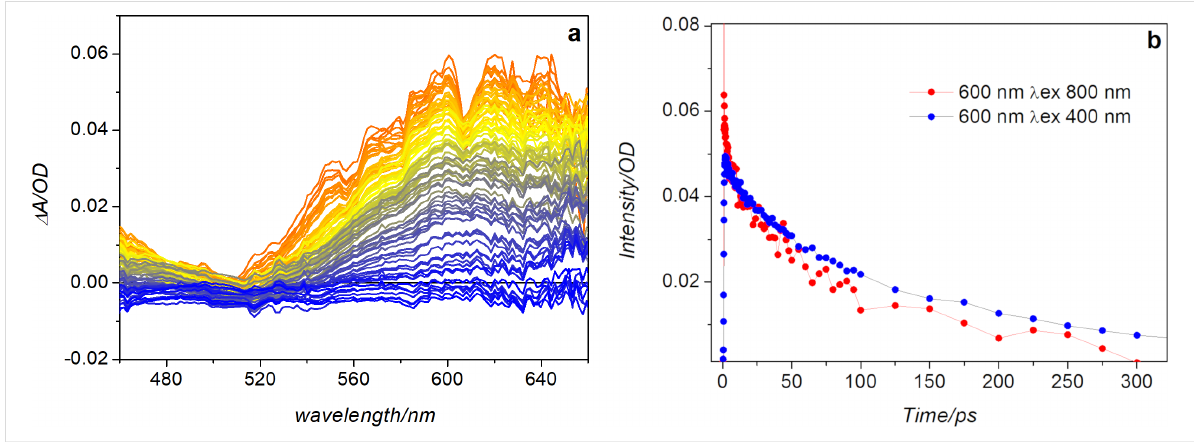
Figure 7: a) Transient absorption spectra measured for hydrazone 1 in toluene upon excitation at 785 nm. b) Comparison of the kinetic traces regis- tered at 600 nm upon excitation at 400 nm and 785 nm.